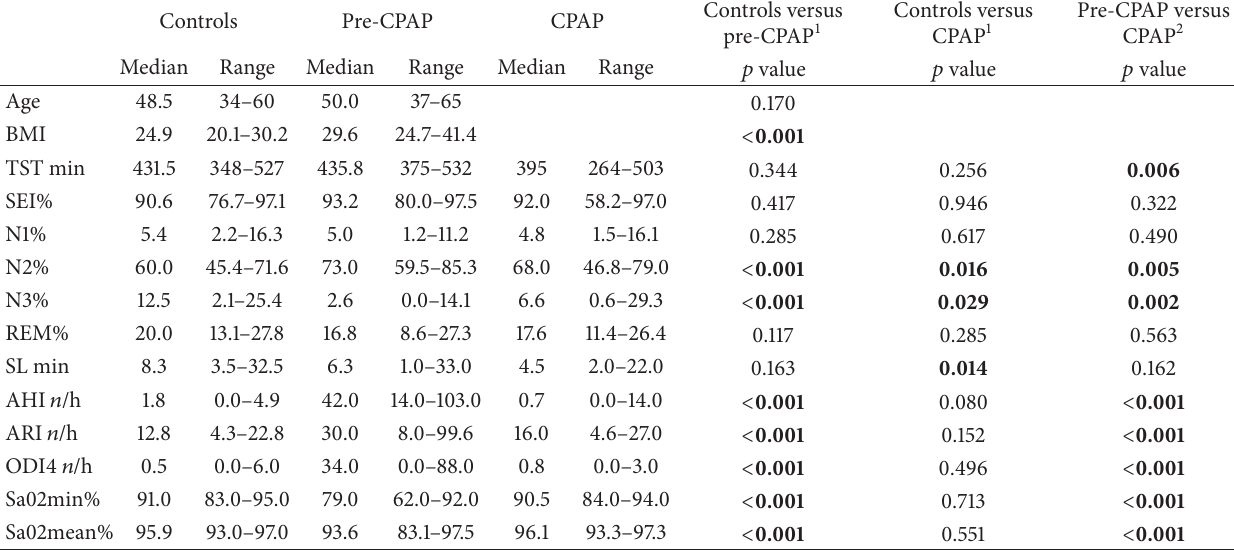
Controls versus pre-CPAP